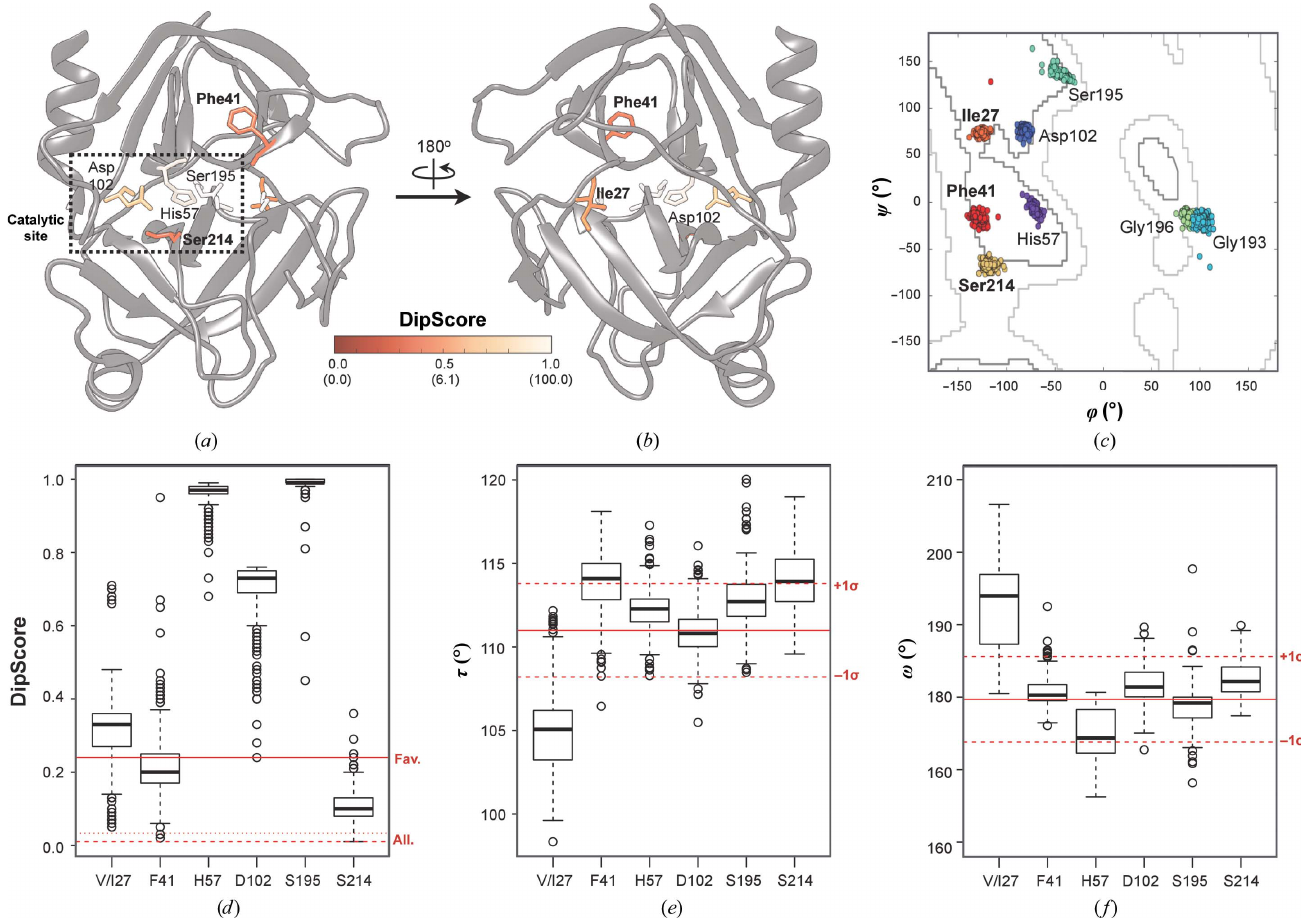
Figure 6 DipSpace-based analysis of the trypsin family. ( a , b ) Cartoon representation of the porcine trypsin model (PDB entry 2a31) viewed from two perspectives. The catalytic residues as well as Phe41 and Ile27 are shown in stick representation and are coloured by DipScore. Values in parentheses indicate the corresponding DipScore percentiles. ( c ) Ramachandran plot for the corresponding catalytic residues as well as Phe41 and Ile27 in all 350 trypsin models considered. The allowed (grey) and favoured (dark grey) boundaries according to Lovell et al. (2003) are marked. ( d , e , f ) Box plots for the ( d ) DipScore, ( e ) (cid:3) angle and ( f ) ! angle for the four main catalytic residues as well as Phe41 and (Val)Ile27. ( d ) The favoured, allowed and generously allowed DipScore thresholds are marked by straight, dotted and dashed red lines, respectively. ( e , f ) The expected average and the 1 (cid:4) intervals according to MacArthur & Thornton (1996) and Engh & Huber (2006) are marked by straight and dashed red lines,